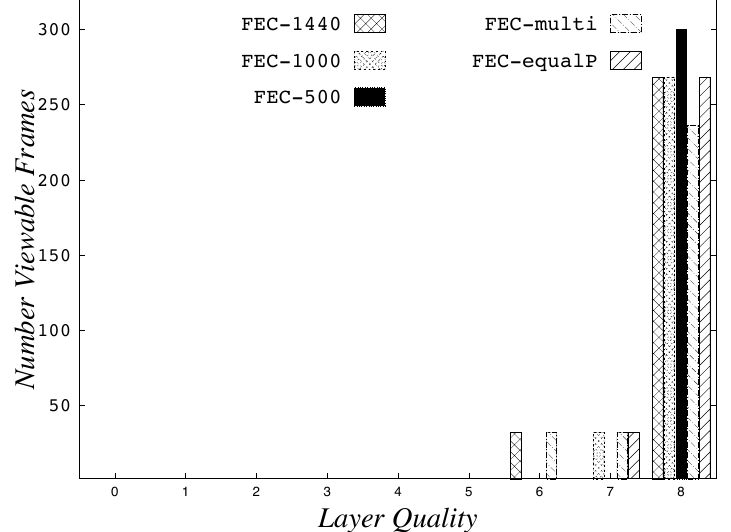
Figure A23. Example of the number of viewable layers for SVC-SC, for each of the FECPacket thres , at a packet loss rate of 10% and a GOP of 32. This image illustrates an increase in the FEC for C1 and C2 based on the worst case scenario, as shown in Table